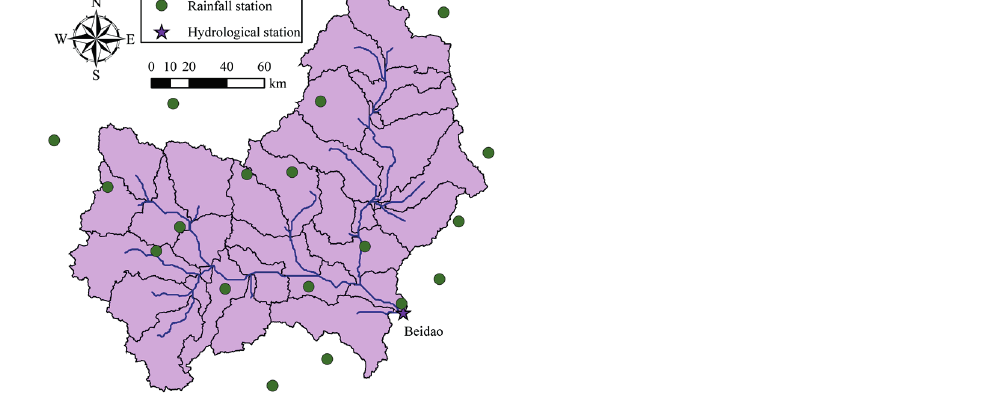
Fig. 2 Location of the rainfall stations and hydrological stations in the Wei River